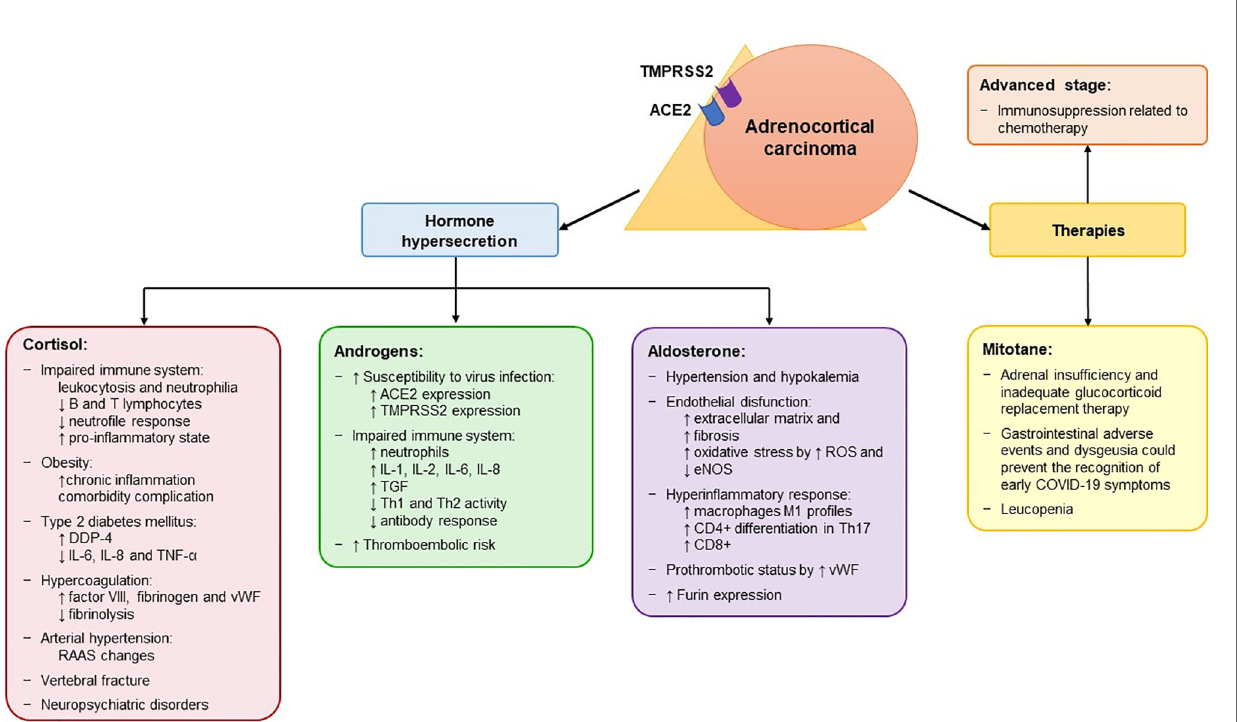
FIGURE 3 | Potential mechanisms associated with an increased risk of contracting SARS-CoV-2 and with a more severe form of the disease in patients with adrenocortical carcinoma. Adrenocortical carcinoma (ACC) expresses both ACE2 and TMPRSS2 at mRNA levels, which encode the receptors that mediate the entry of SARS-CoV-2 into the host cell. The peculiarity of ACC is its hormone secretion (in 50-60% of patients), resulting in hypercortisolism, hyperandrogenism and hyperaldosteronism. In addition, it is treated with mitotane therapy, which is used both as adjuvant treatment and in advanced cases and induces adrenal insuf fi ciency. The effects of the hormone secretion and of mitotane are listed in the corresponding box. In addition, ACC patients also present other cancer-related factors that are associated with a high risk of severe manifestations of SARS-CoV-2, including advanced stage and immunosuppression related to chemotherapy. ACE2, angiotensin converting enzyme 2; eNOS, endothelial nitric oxide synthase; ROS, reactive oxygen species; TMPRSS2, transmembrane protease serine 2; vWF, von Willebrand factor; ↑ , increased; ↓ , decreased; RAAS, Renin-Angiotensin-Aldosterone System; DDP-4, dipeptidyl peptidase 4; IL, interleukine; TGF, tumor growth factor; Th, T